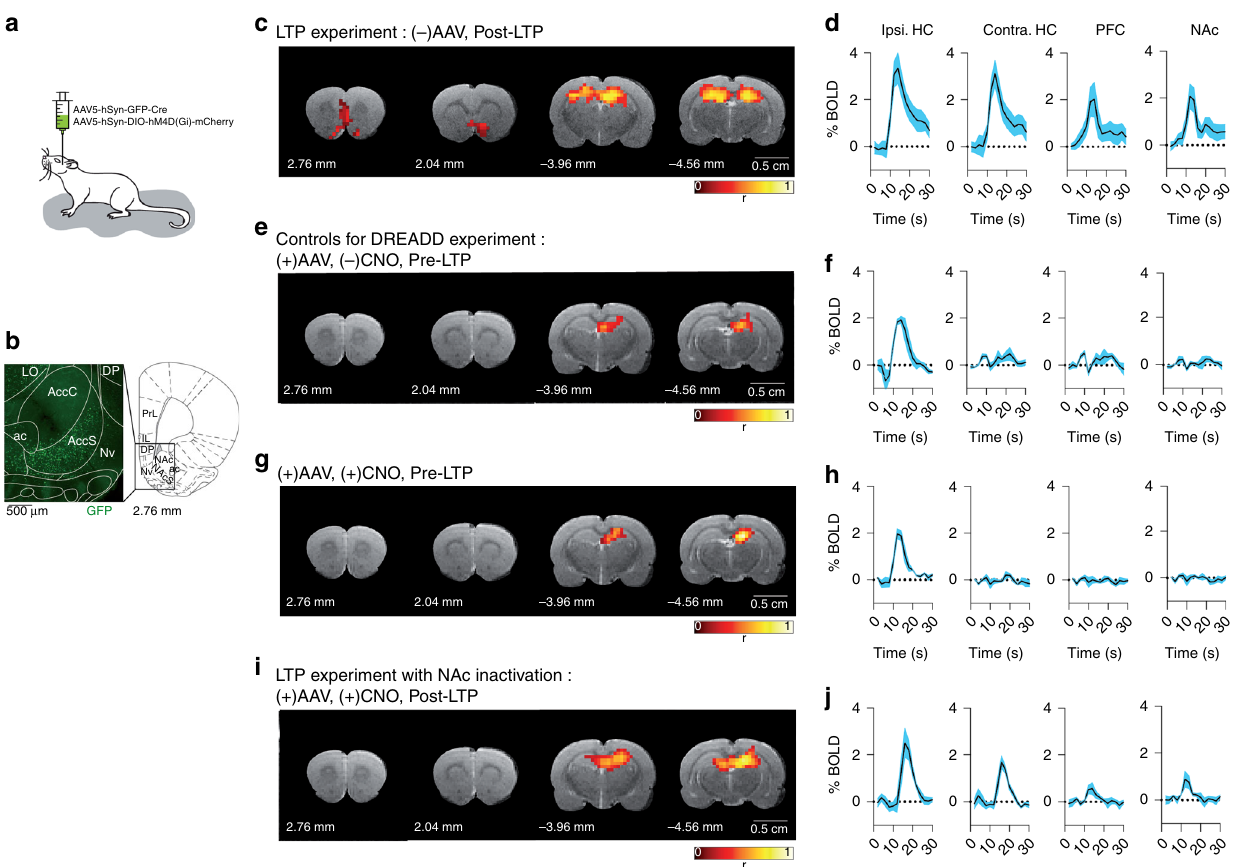
Fig. 4 Experimental test of essential nodes. a The inhibitory version of DREADD receptors (hM4Di) is expressed in the NAc shell using a combination of two adenoassociated viruses (AAVs) injected stereotactically in the region as indicated (see Supplementary Note 8 for details). b Histological veri fi cation 4 weeks after the viral infection showing green fl uorescence protein (GFP) in the neurons that positively express the construct. For anatomical reference, an image of the rat brain atlas is shown. Inset: 20× magni fi cation picture of the same slice demonstrating selective infection of neurons in the NAc shell. c , 43 e , g , i Single subject statistically thresholded fMRI maps showing voxels activated ( p < 0.001, corrected) by perforant path stimulation and overlaid on an anatomical T2-weighted image. d , f , h , j BOLD time courses from signi fi cantly activated voxels averaged from the indicated regions of interests and across animals (mean ± SEM; n = 6 for c , n = 3 for e , g , and i ). Details on fMRI processing and statistics are given in Supplementary Notes 2 and 8. c LTP experiment for comparison (( − ) AAV infection, ( − ) CNO administration) showing the expected activation of HC, PFC, and NAc in POST-LTP. Note the evoked BOLD responses bilaterally in the HC ( d ), a landmark of HC response after LTP induction. e AAV infection in the NAc (( + ) AAV, ( − ) CNO) preserves activation of the HC under perforant path stimulation before LTP. g Inactivating the NAc by administration of CNO in the same animal (( + ) AAV, ( + ) CNO) does not alter functional maps nor BOLD responses in the baseline (PRE-LTP) condition (compare e vs. g ). BOLD signal responses ( f , h ) are only evident in the ipsilateral HC as expected from PRE-LTP condition. i , j NAc inactivation (( + ) AAV, ( + ) CNO) prevents the integration of the